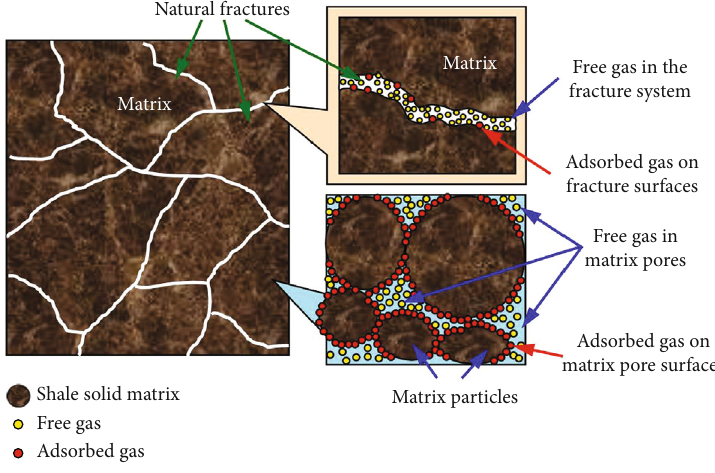
Figure 4: Schematic of gas storage in shale gas reservoirs [1,